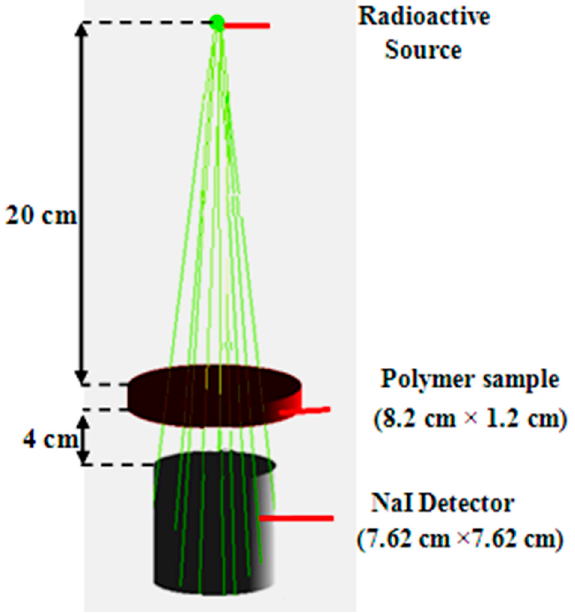
Figure 1. Sketch of the used Geant4 simulation geometry set-up.